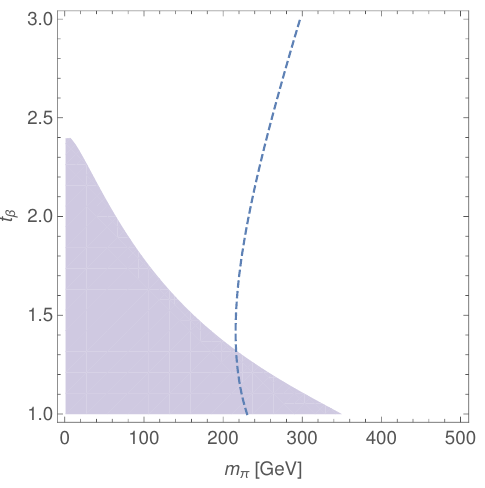
Figure 8 . Excluded region by B 0 (cid:0) B 0 mixing. The dashed curve shows the value of m (cid:25) calculated for the benchmark scenario with m 2